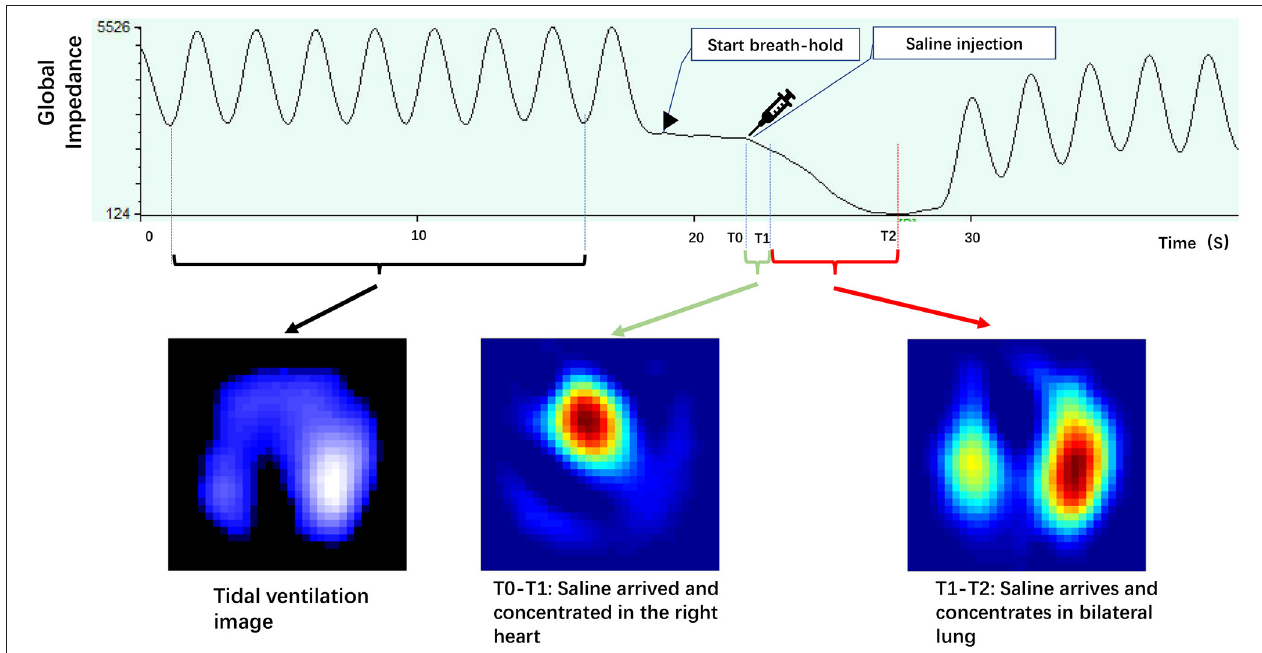
FIGURE 1 | Illustrates impedance–time curves and corresponding ventilation/perfusion images during the saline bolus. The tidal impedance variation during normal tidal breathing before apnea was used to calculate the tidal ventilation image. The impedance–time curve caused by saline bolus during the apnea period was used for the perfusion image (adapted from our recent